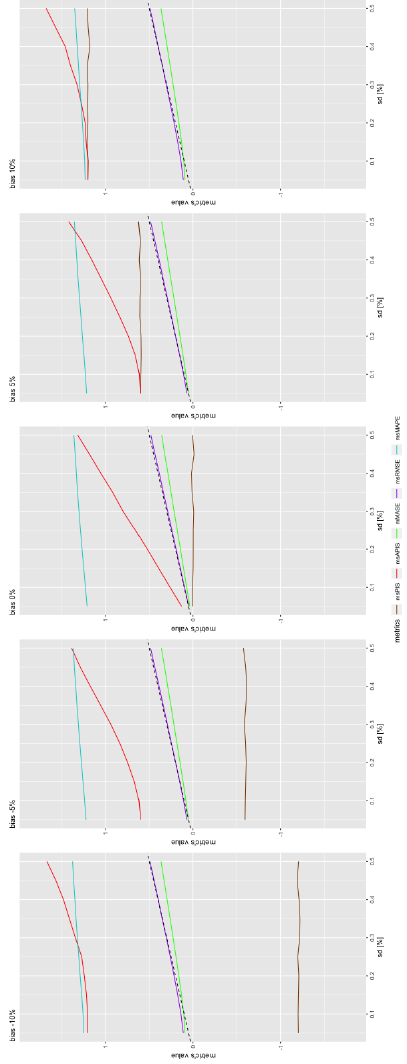
Figure 5. Impact of change in bias on the different performance